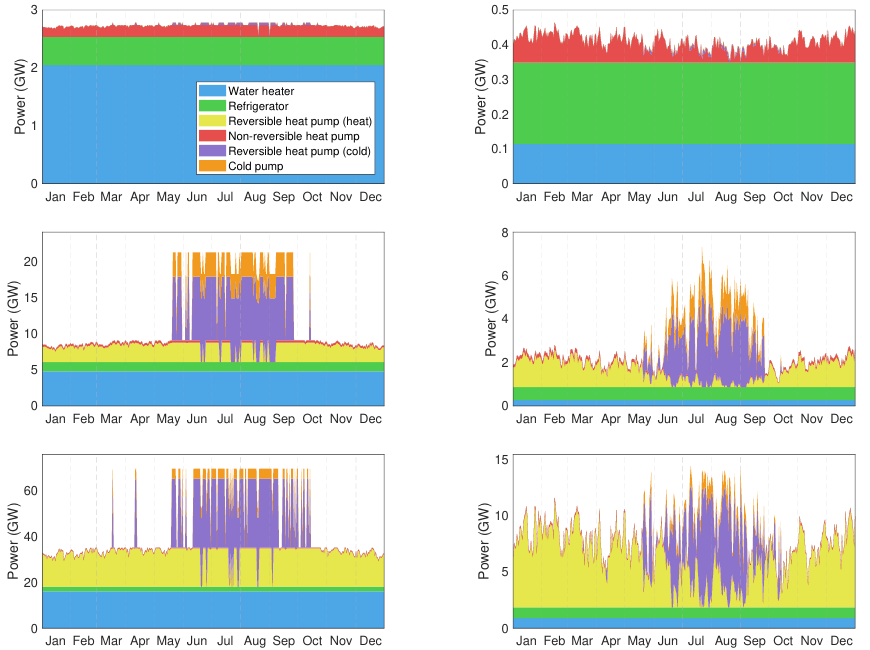
Figure 5. Maximum charging power ( left ) and maximum discharging power ( right ) in North Atlantic, Continental, and Mediterranean climate areas in